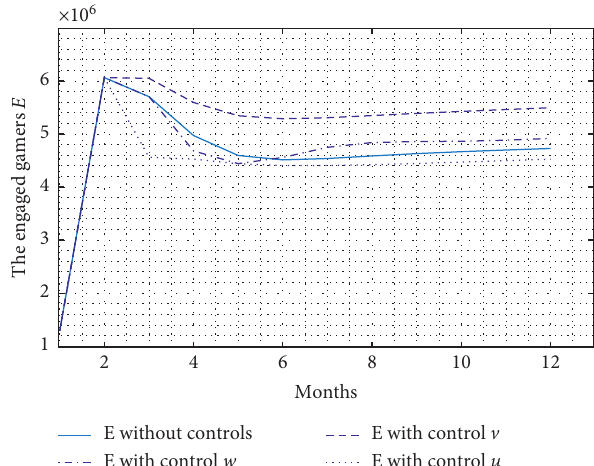
Figure 5: Development of the number of the engaged gamers with one control in a few